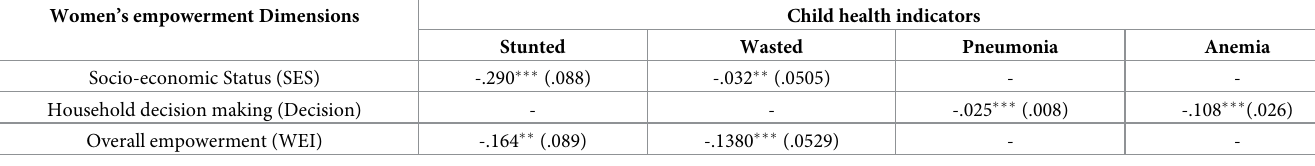
Table 4. The marginal effects of women’s empowerment on children’s health status.